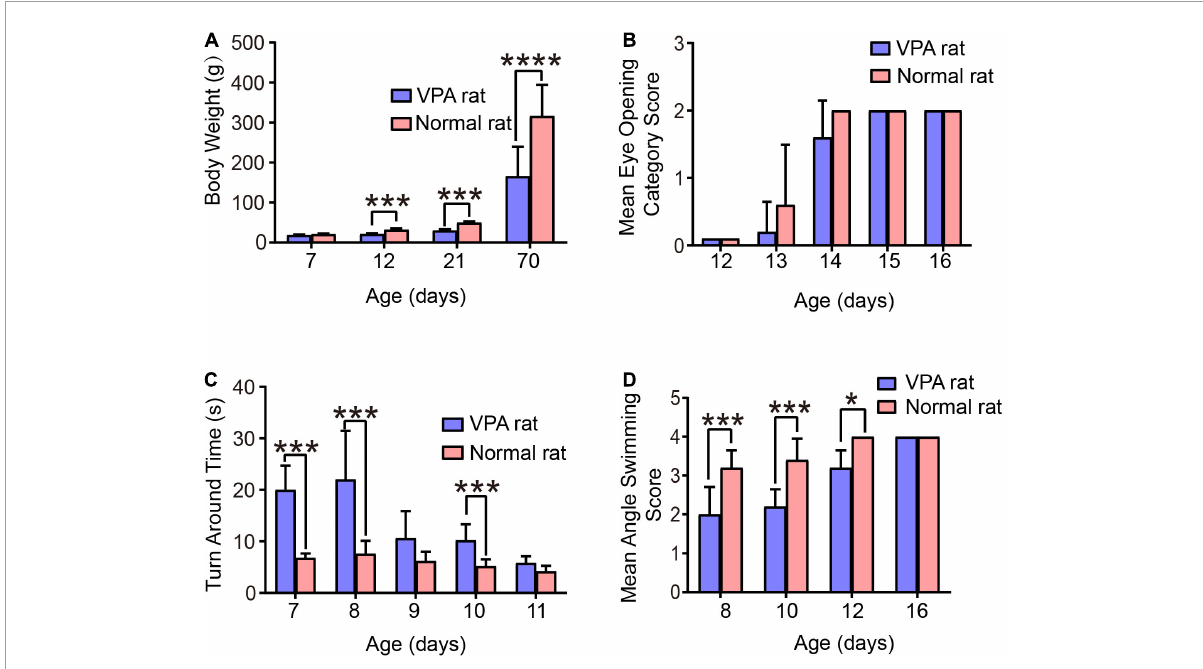
FIGURE4 Behavioral evaluation of the VPA-induced autism rats. (A) Body weight of rats. (B) Eye-opening score of rats. (C) Time taken for rats to turn 180 ◦ . (D) Head position score of rats during swimming. * p < 0.05, *** p < 0.001, **** p <